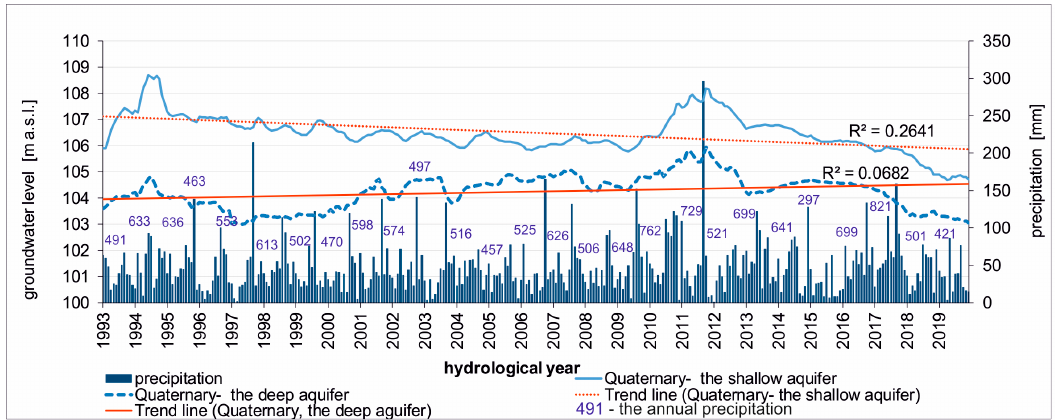
Figure 4. Monthly average groundwater levels of Quaternary aquifers. Table 3. Sen’s slope trend water table position.